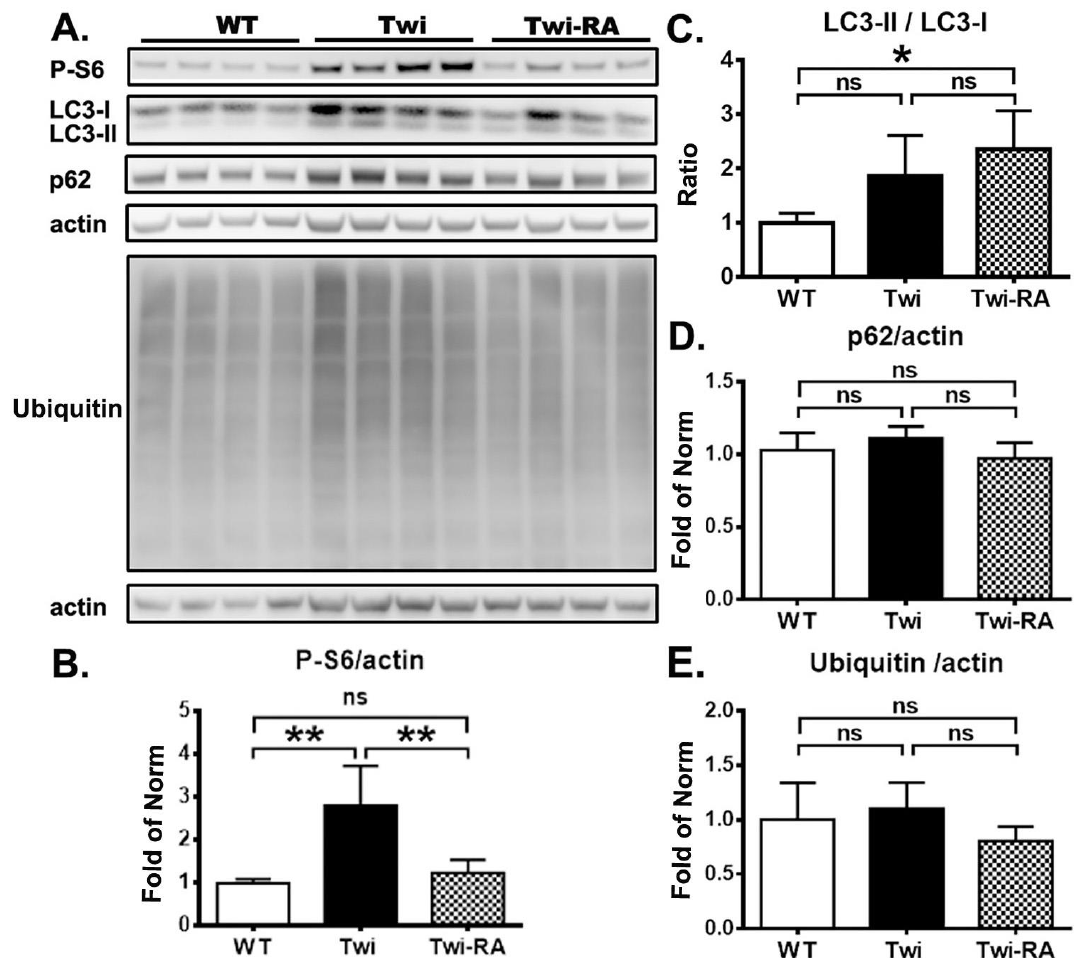
Figure 1. Rapamycin upregulates autophagy. ( A ) Proteins were extracted from Triton-X buffer (soluble fraction). Immunoblotting analyzed for autophagy related proteins phospho-S6 (P-S6), LC3-I, LC3-II, sequestosome1/p62 (p62), and ubiquitin in brain stem from wild-type (WT), untreated twitcher (Twi), and rapamycin-treated twitcher (Twi-RA) mice at 35 days of age. Quantitative analysis of the results of immunoblots are shown in ( B ) for P-S6, in ( C ) for LC3 II/LC3-I ratio, in ( D ) for p62, and in ( E ) for ubiquitin. Protein levels are normalized to actin. Values are expressed as mean ± SD and compared using One way ANOVA (Tukey post hoc test). ( n = 4). Statistical significance, * p < 0.05, ** p < 0.01, and ns (not significant).